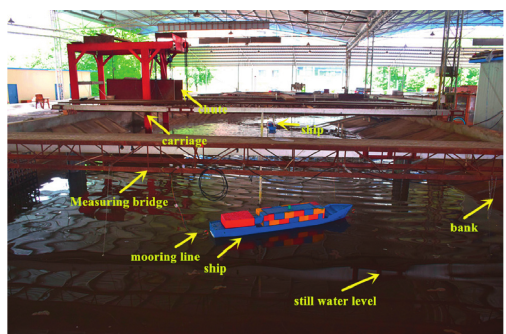
Figure 4: Solid model diagram of the channel.